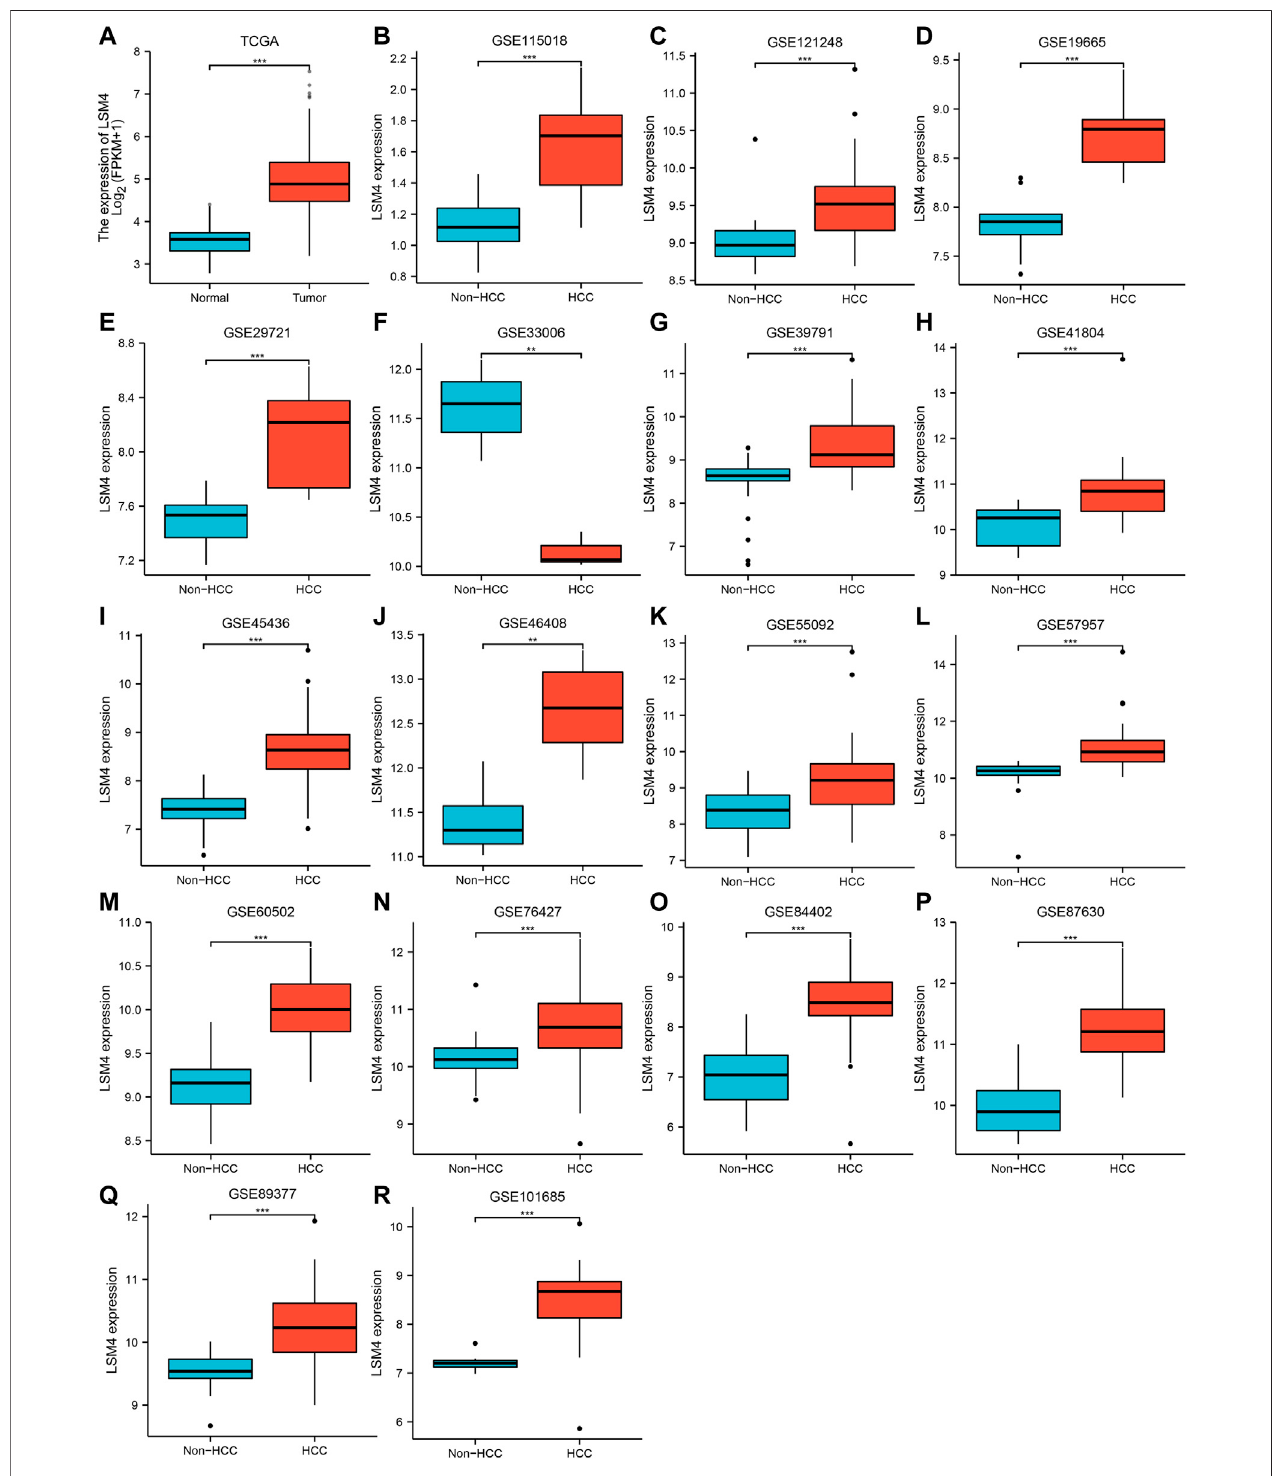
FIGURE1| LSM4 expressioninhepatocellularcarcinoma. LSM4 expressionbetweennon-HCCtissuesandHCCtissuesbasedonGEOandTCGAdatasets(* p < 0.05, ** p < 0.01, *** p < 0.001). (A) TCGA. (B) GSE115018. (C) GSE121248. (D) GSE19665. (E) GSE29721. (F) GSE33006. (G) GSE39791. (H) GSE41804. (I) GSE45436. (J) GSE46408. (K) GSE55092. (L) GSE57957. (M) GSE60502. (N) GSE76427. (O) GSE84402. (P) GSE87630. (Q) GSE8937. (R) GSE101685.